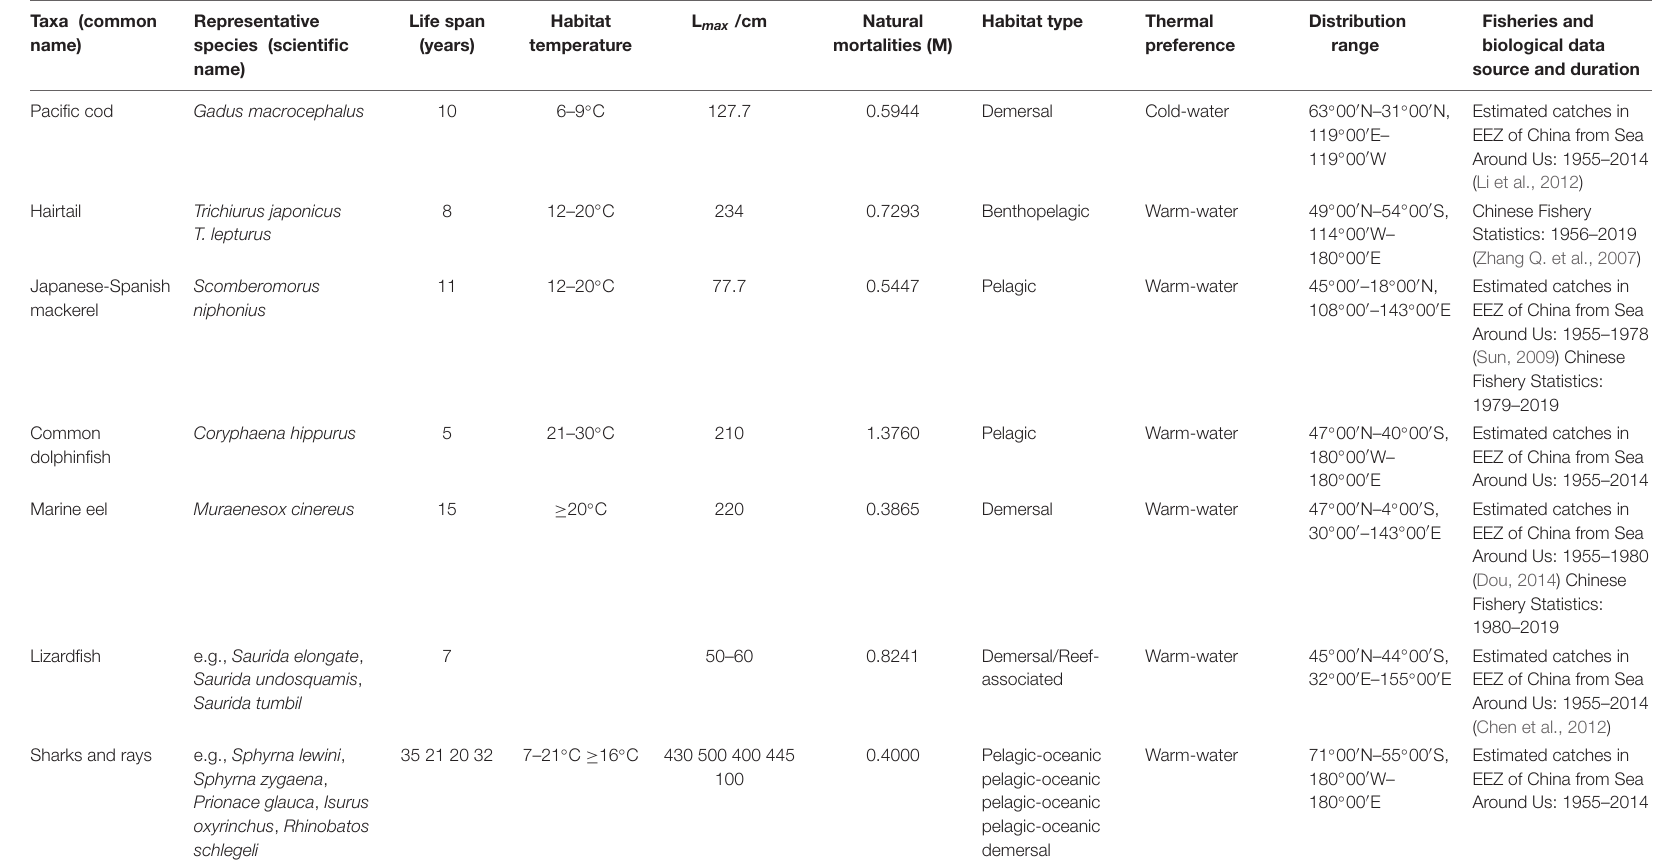
TABLE 1 | Ecological and fisheries characteristics for the seven piscivorous fishes in the China